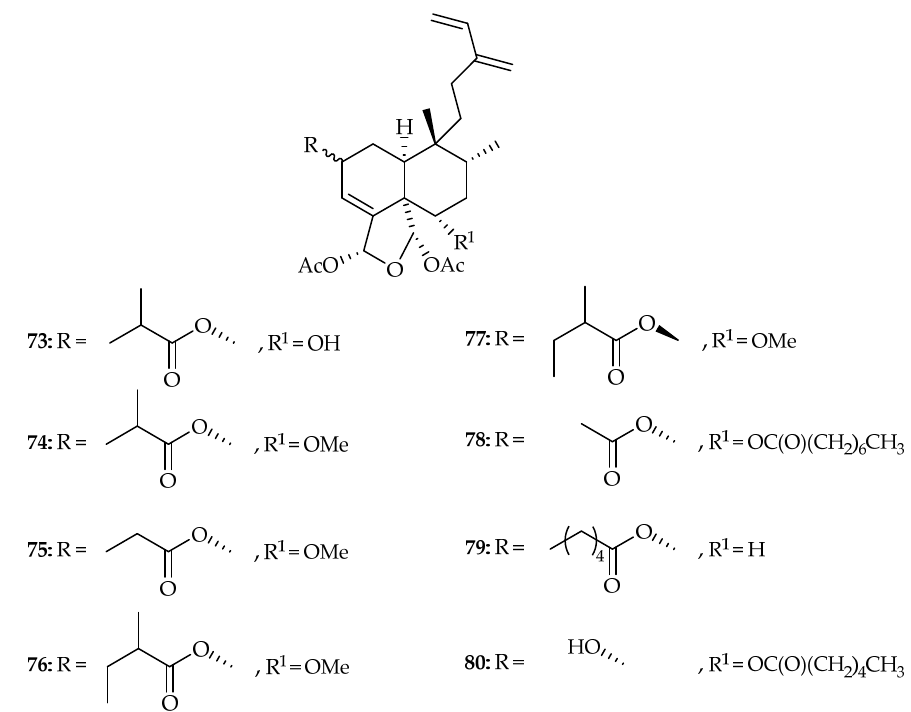
Figure 30. Structures of crispene F 71 [48] and crispene G 72 [48]. The isozuelanin-type clerodane diterpenes corymbulosins I, K, L, N, O, P, T, and V 73 – 80 were isolated from the bark of Laetia corymbulosa (Salicaceae) (Figure 31). The absolute configurations of the newly isolated compounds were determined through electronic circular dichroism (ECD) experiments, X-ray analysis, and modified Mosher ester method. The antiproliferative activities of the diterpenes 73–80 were evaluated using A549, MDA-MB-231, MCF-7, KB, and KB-VIN cell lines. They all showed inhibitory effects on the cell proliferation of these five cancer cells, with IC 50 values in the range of 0.45–6.39 µ M, using paclitaxel as a positive control. The effects of the potent compounds corymbulosin I 73 and corymbulosin K 74 on cell cycle progression in the MDA-MB-231 cell line were further investigated by flow cytometry [49].